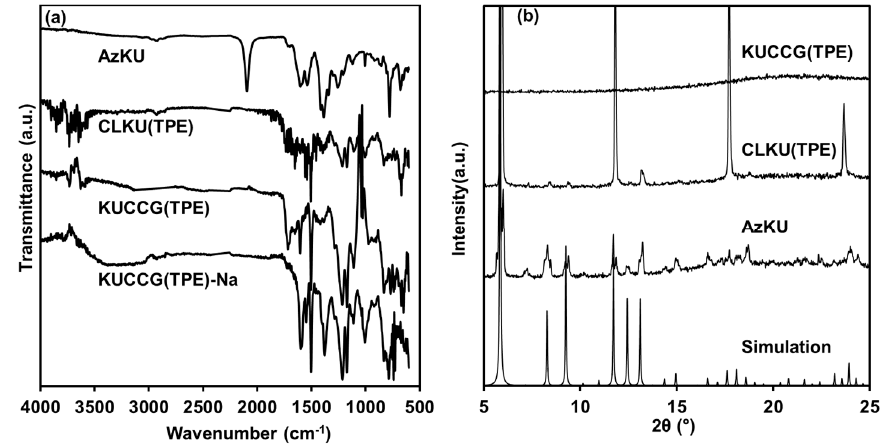
Figure 2. ( a ) Fourier transform infrared (FT-IR) spectra of AzKU, CLKU(TPE), KUCCG(TPE), and KUCCG(TPE)-Na; ( b ) XRD patterns of AzKU, CLKU(TPE), and KUCCG(TPE), and simulated pattern of KUMOF from single crystal data.